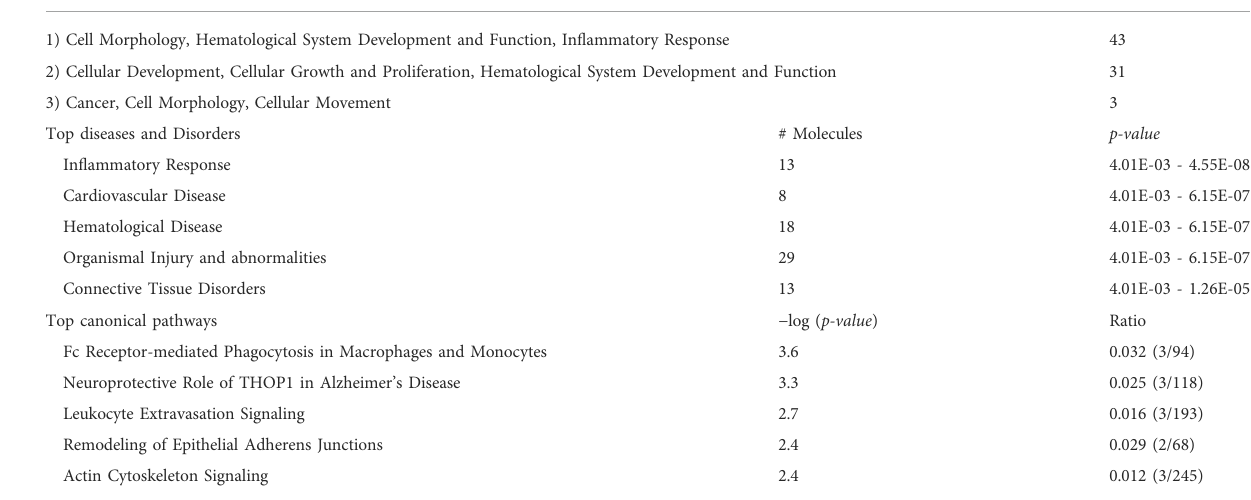
TABLE 1 Ingenuity pathway analysis results. Top